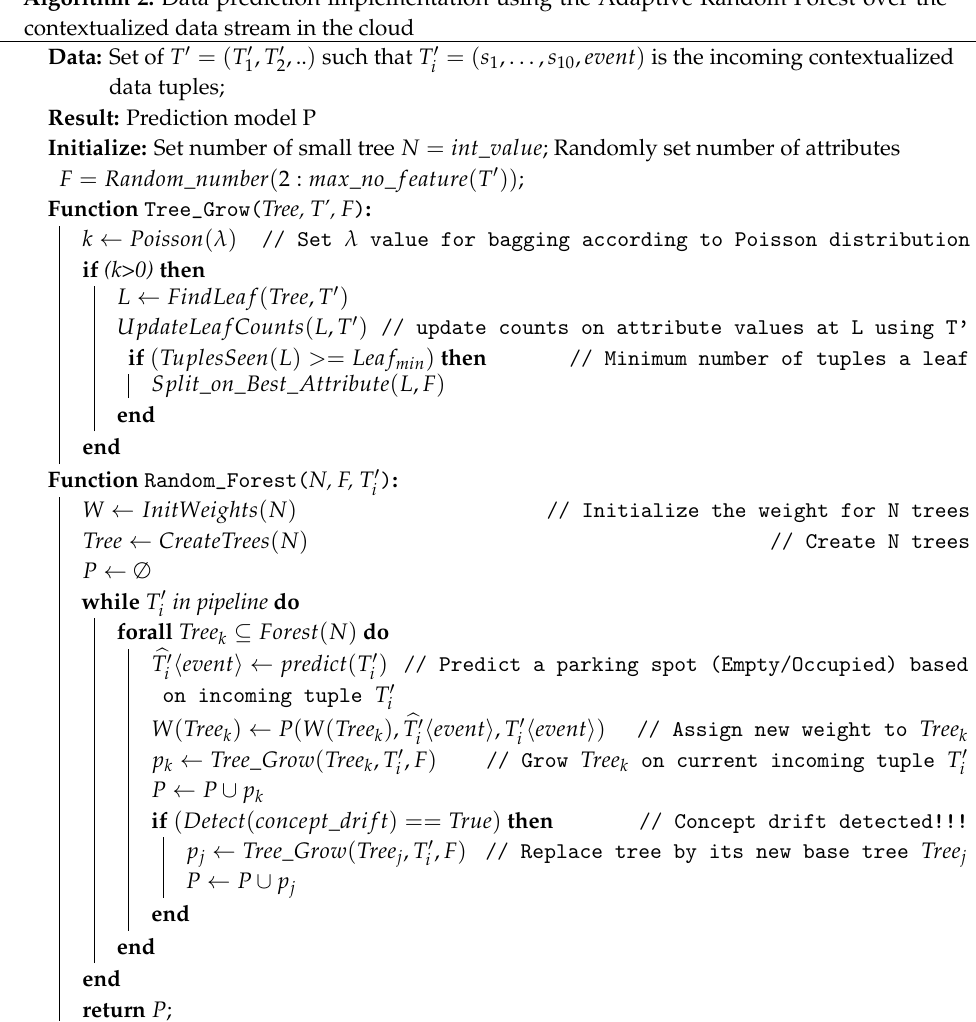
Algorithm 2: Data prediction implementation using the Adaptive Random Forest over the contextualized data stream in the